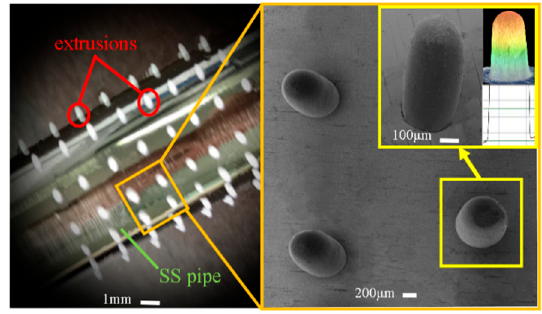
Figure 14. E lectroforming mandrel with cylindrical dome extrusion polymer pattern. Figure 14. Electroforming mandrel with cylindrical dome extrusion polymer pattern. Micromachines 2020 , 11 , x